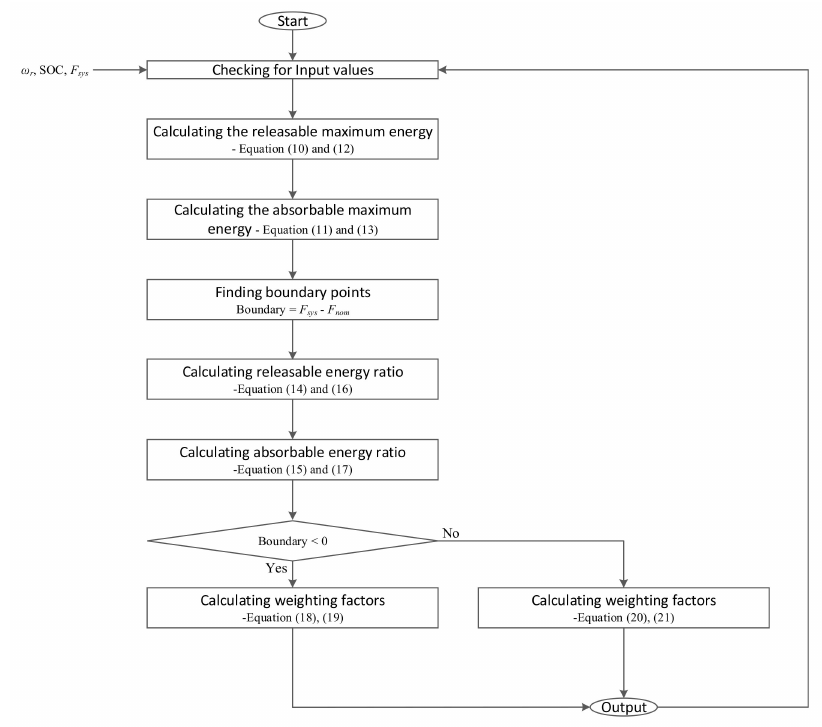
Figure 5. Flowchart for the coordinated frequency stabilization between a WTG and